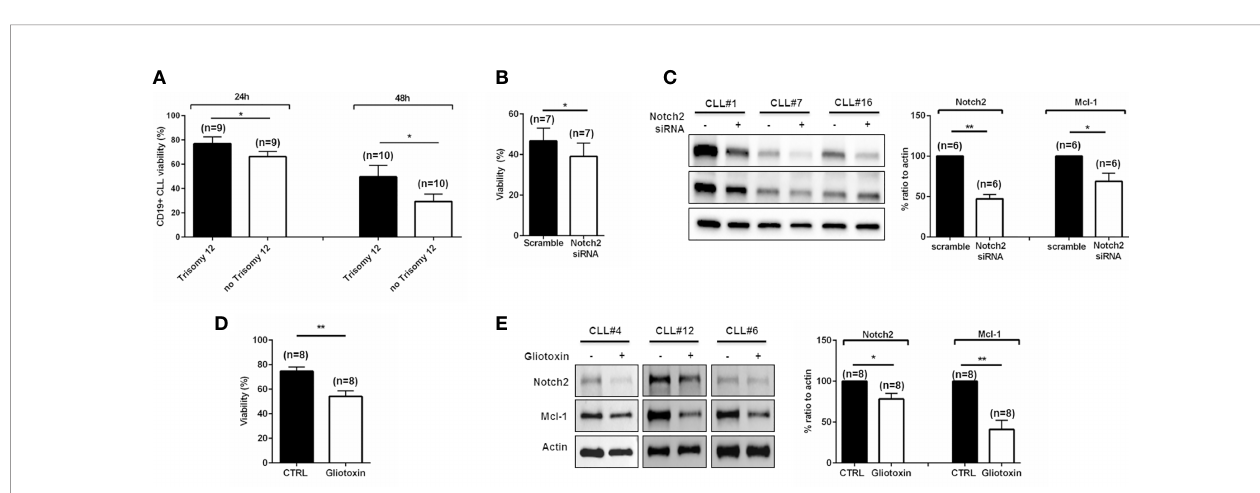
FIGURE 3 | Notch2 is involved in trisomy 12 chronic lymphocytic leukemia (CLL) cell survival. (A) Bar diagrams show the percentage of CD19+ CLL cell viability cultured in complete medium for 24 and 48 h. Comparison was performed between trisomy 12 CLL cells and no trisomy 12 (*p < 0.05). (B) CLL cells were transfected with scramble or Notch2 siRNA, and bar diagram shows the viability measured after 24 h by fl ow cytometry (*p < 0.05). (C) Immunoblots show Notch2 and Mcl-1 levels after transfection with Notch2 siRNA in three representative samples. On the right, bar diagrams show densitometric quanti fi cation of Notch2 and Mcl-1 in trisomy 12 CLL cells after transfection with scramble or Notch2 siRNA (*p < 0.05). (D) CLL cells were cultured in the presence of gliotoxin, a speci fi c inhibitor of Notch2. Bar diagrams show the percentage of CLL cell viability after 3 h of treatment (**p < 0.01). (E) Immunoblots show Notch2 and Mcl-1 levels after treatment with gliotoxin in three representative samples. Bar diagrams show the densitometric quanti fi cation of Notch2 and Mcl-1 in +12 CLL cells treated with gliotoxin (*p < 0.05, **p <